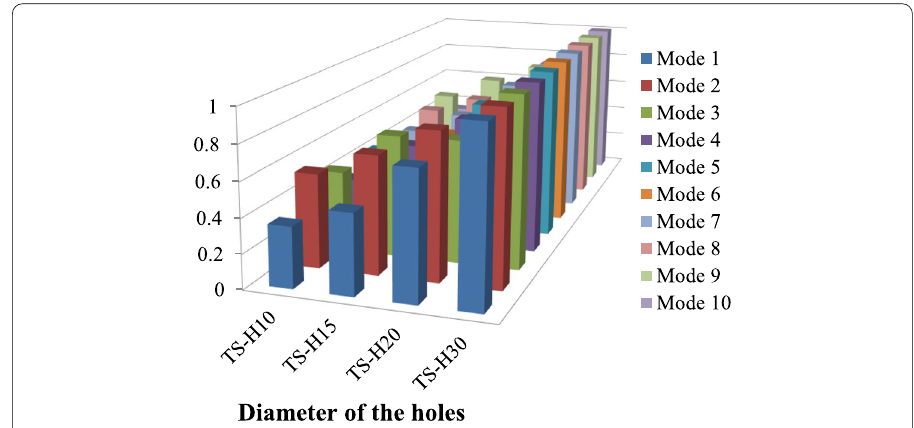
Fig. 24 Comparison of frequencies for the plates with a transverse stiffener and with